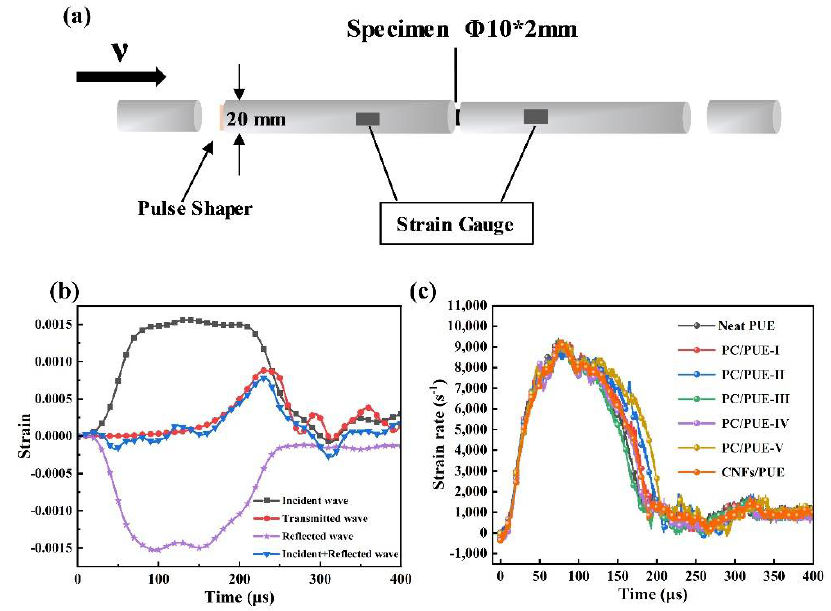
Figure 6. ( a ) SHPB apparatus schematic diagram, ( b ) raw data for SHPB calibration, ( c ) the strain rate of PUE composites after SHPB impact.